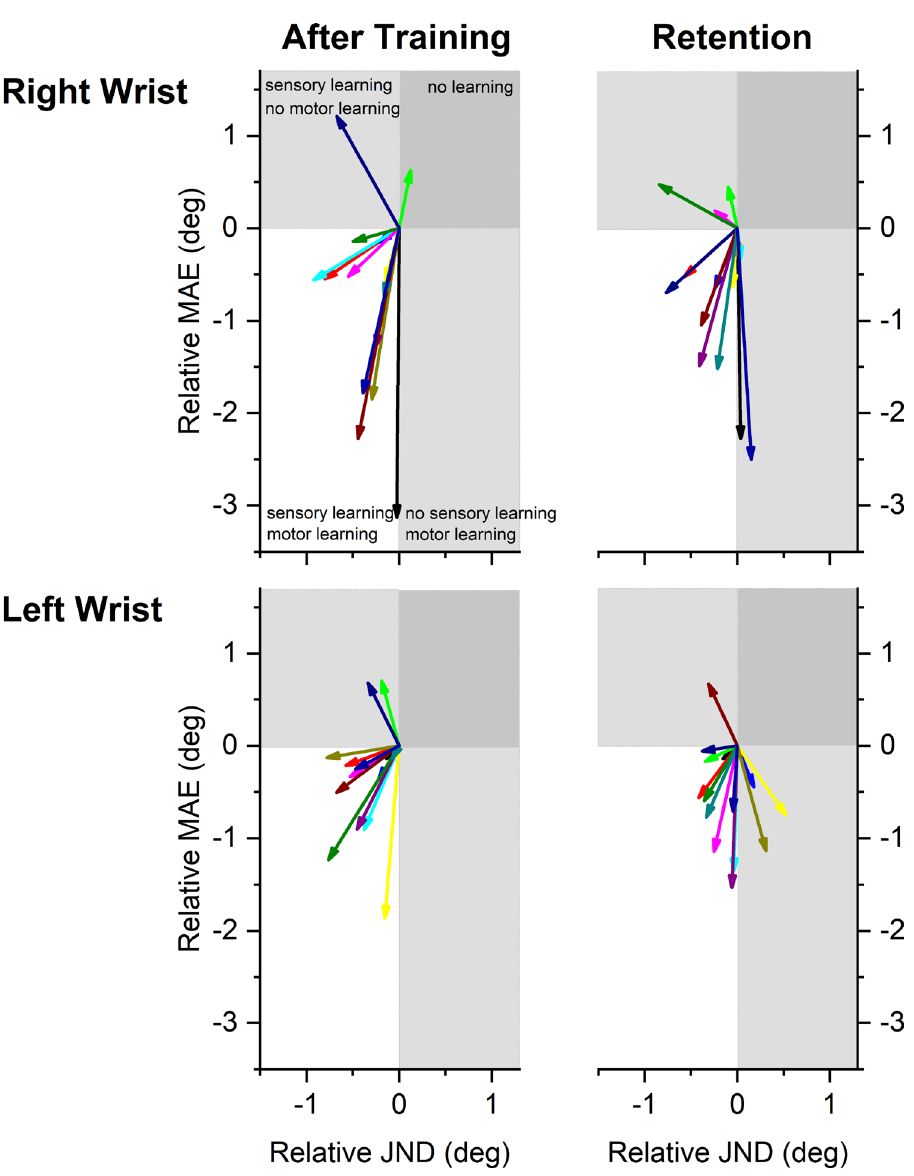
Figure 4. Vectorgram indicating the relationship between proprioceptive and motor learning at both wrist at posttest and retention. Each vector depicts a participant’s relative change in position sense threshold (JND) and spatial motor error (MAE) relative to pretest or retention. The coordinates of baseline JND and MAE are aligned to the origin (0, 0). Vector length indicates amount of relative change with respect to baseline. The lower left quadrant represents the zone where both proprioceptive and motor learning